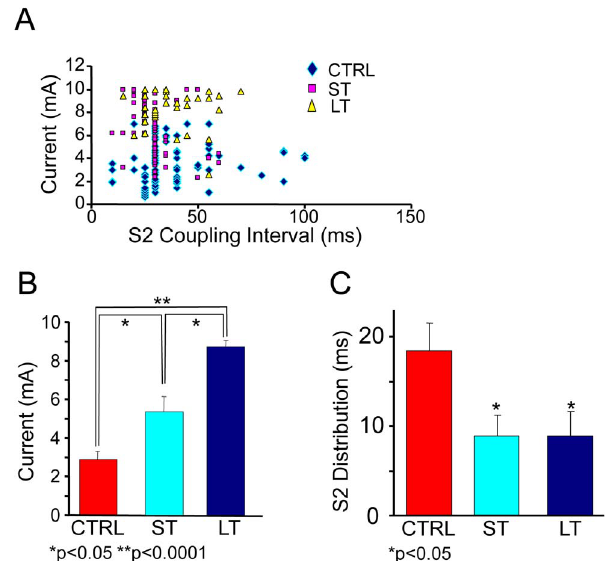
Figure 3. Induction of VF and exercise intensity. A. Current intensity and S 2 interval for VF induction in individual experiments for the 3 groups. B. Threshold current for VF induction in the studied groups (p , 0.05 for ST compared to LT and CTRL, p , 0.0001 for LT compared to CTRL). C. The relationship between the exercise intensity (the different groups) and the distribution of stimulus coupling interval S 2 that induces VF in the studied group (ST and LT compared to CTRL).